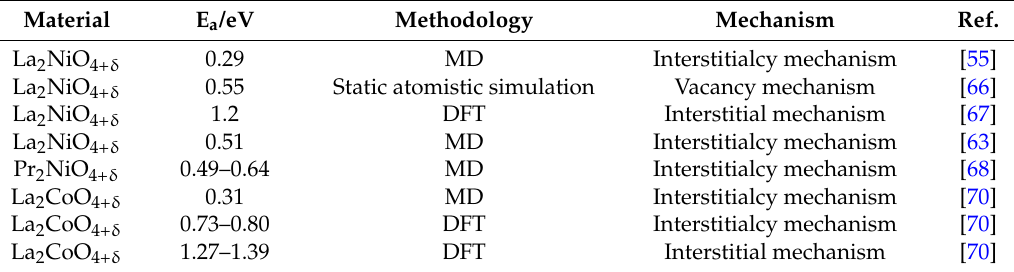
Figure 2. ( a ) Relaxed configuration of the La 2 CoO 4+ δ model. Circled region represents an interstitial oxygen atom; and ( b ) migration paths in simulation. ( I ) indicates an interstitial migration mechanism where an oxygen interstitial atom at the A site directly hops to the adjacent interstitial site A’; ( II ) shows an interstitialcy migration mechanism. An oxygen interstitial atom at the A site kicks the oxygen atom at the B site out of the LaO plane, sending it to the next interstitial site C, and placing itself on the B site on the LaO plane. Reprinted from Ref. [70] with permission of The Royal Society of Chemistry Table 1. Oxygen ion migration energies in the a-b plane of various A 2 BO 4+ δ .